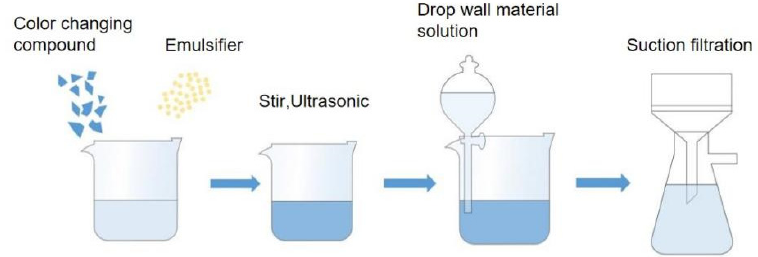
Figure 1. Microcapsule preparation process flowchart.